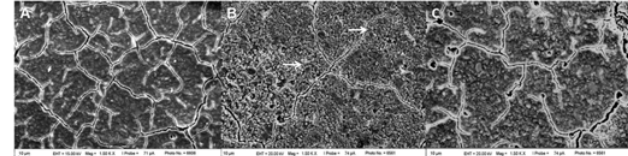
Fig.1. SEM images of the surface morphology for the Riva Protect group (1500 X): (A) baseline; (B) after erosive challenge and (C) after saliva immersion; ( (cid:74) ): filler particles.